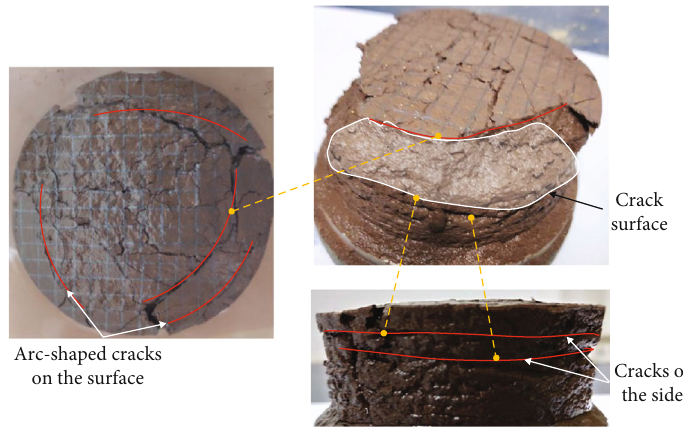
Figure 22: Cracks of 4#